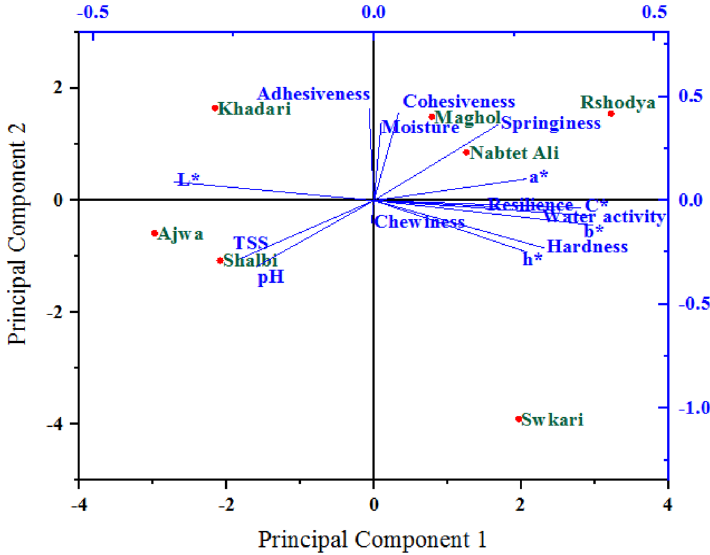
Figure 8. A biplot diagram based on PC1 and PC2 shows similarities and dissimilarities in relationships among the measured variables across different varieties of palm dates under untreated.